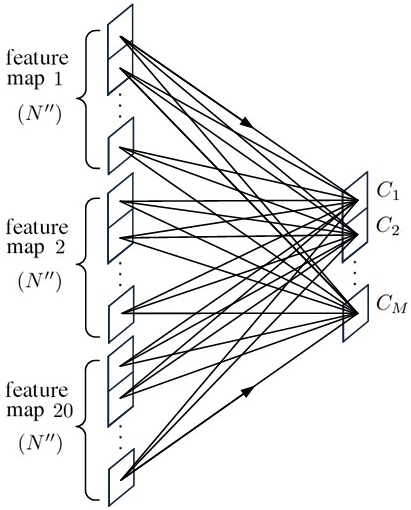
Figure 5. Schematic of FC ( 20 N (cid:48)(cid:48) × M )